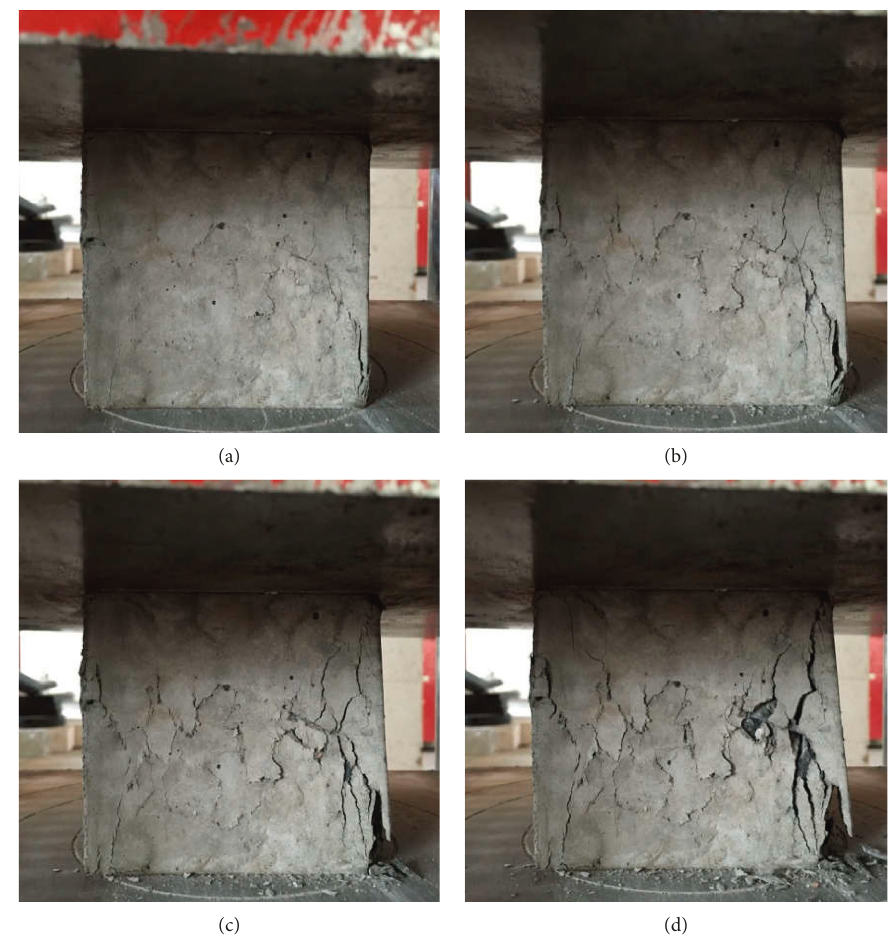
Figure 6: Failure process of a cubic specimen of directionally distributed SFRC under (parallel) compressive loading.